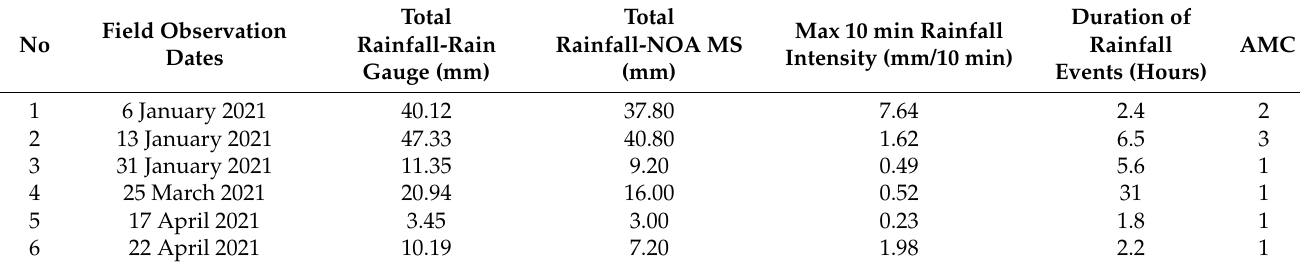
Table 1. Field observation dates and the rainfall characteristics of the rainfall events and the 5 days’ Antecedent Moisture Conditions (AMC).